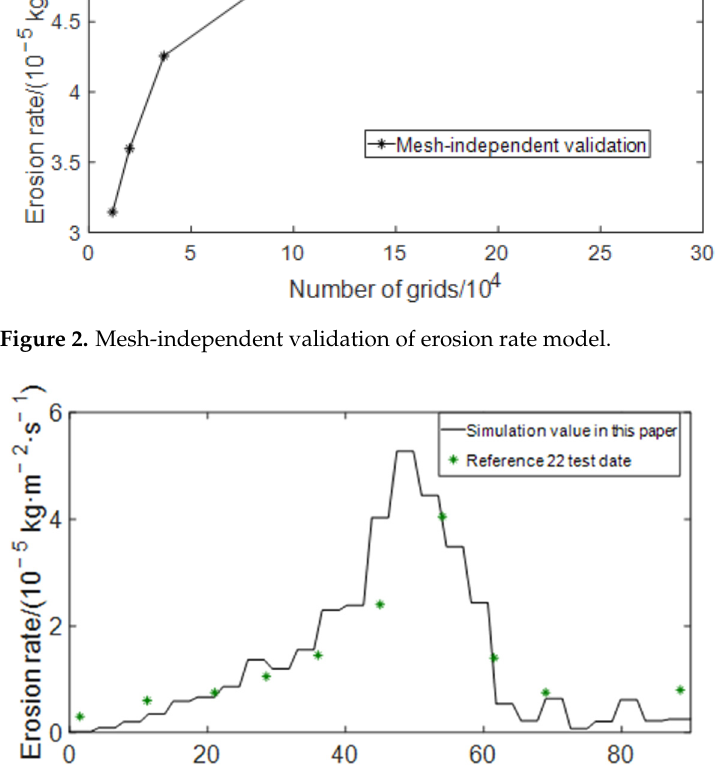
Figure 2. Mesh-independent validation of erosion rate model.